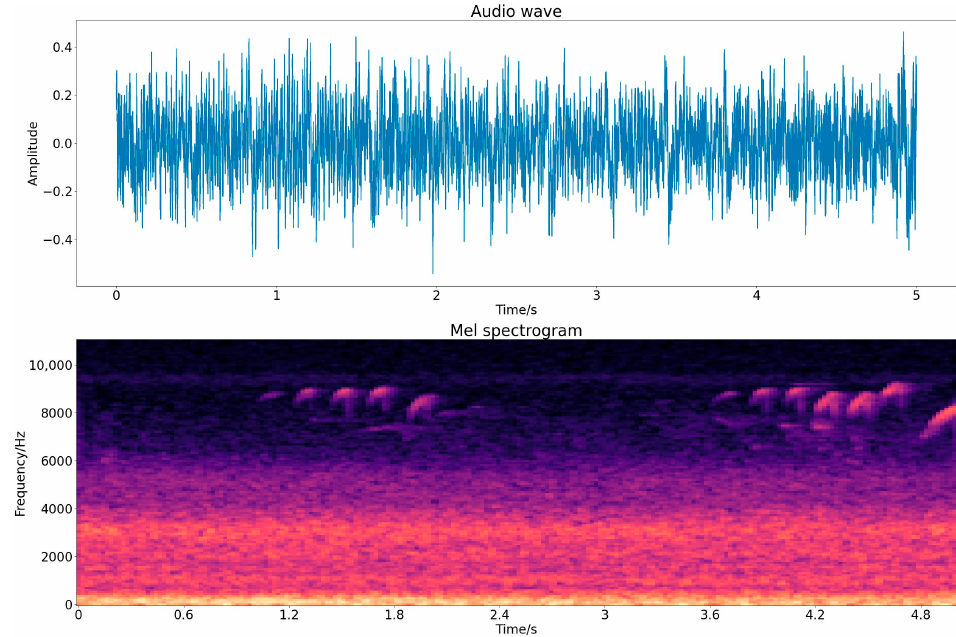
Figure 3. Waveforms of bird calls and the corresponding mel